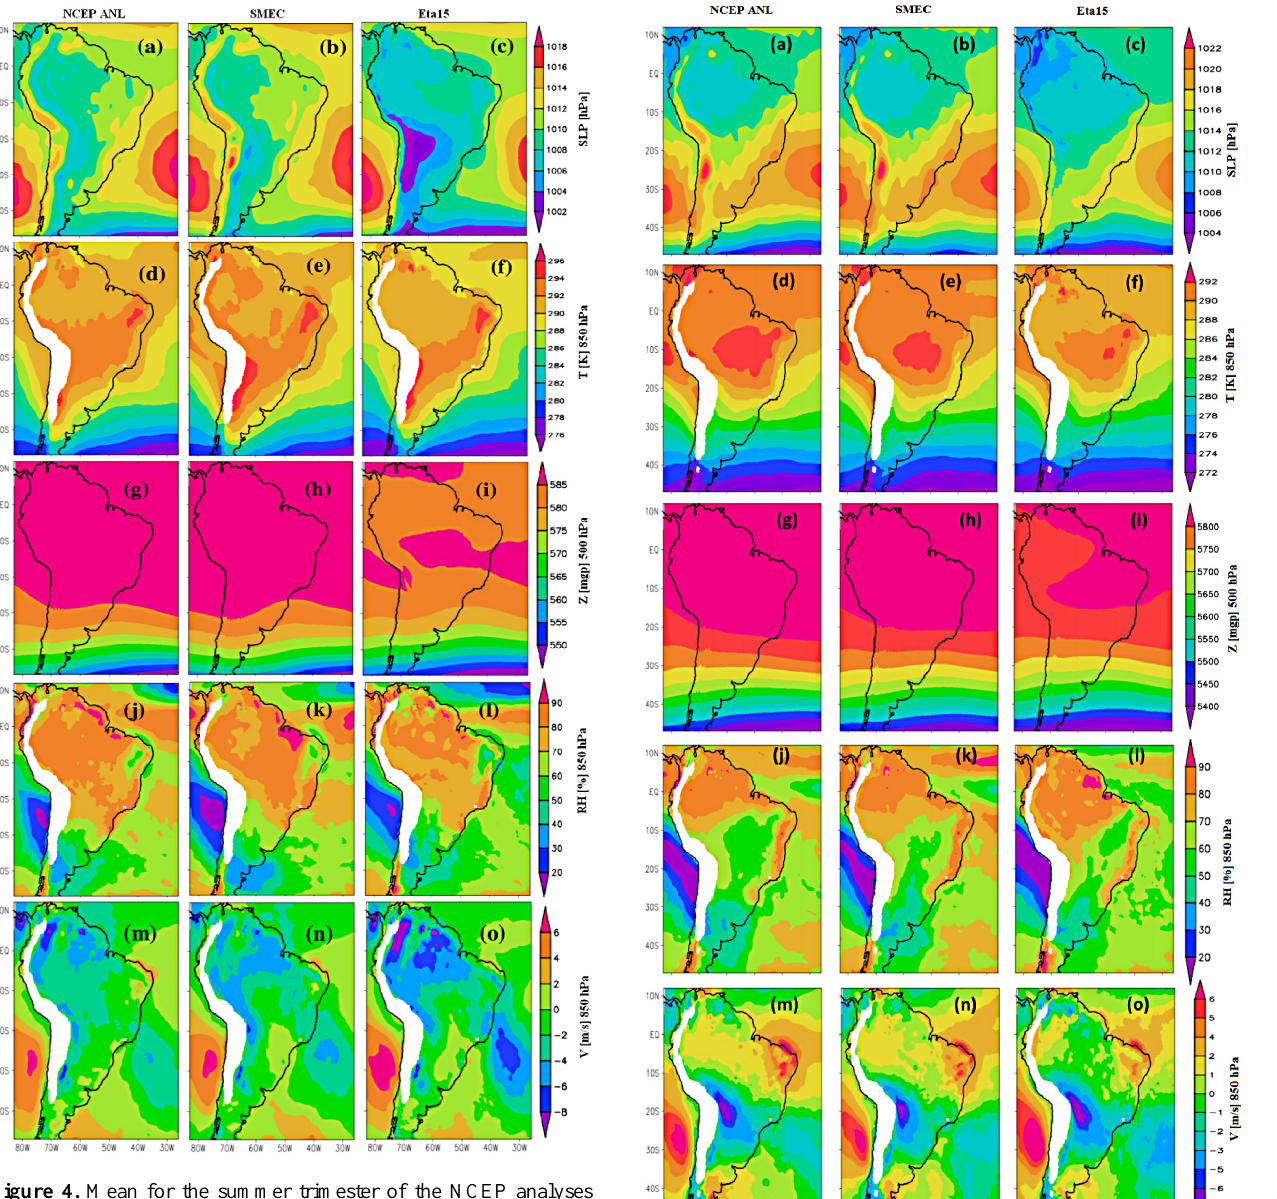
Figure 4. Mean for the summer trimester of the NCEP analyses (first column), and 168h forecasts from the SMEC (second col- umn) and Eta15 (third column) for mean sea level pressure (a, b, c) , 850hPa temperature (d, e, f) , 500hPa geopotential (g, h, i) , rel- ative humidity (j, k, l) and 850hPa meridional wind (m, n, o) .